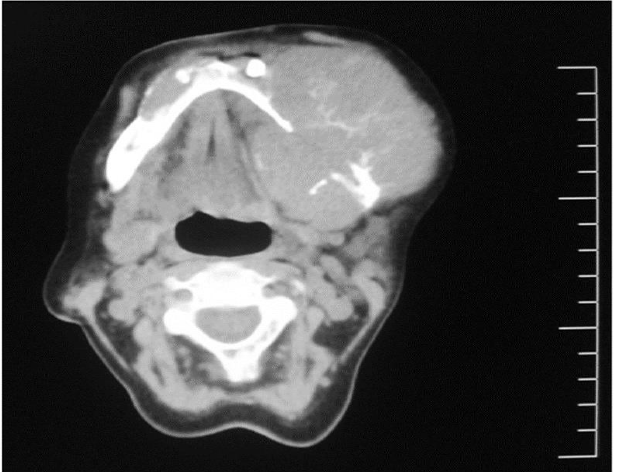
Fig. 4. The head CT scan showed a hypodense mass on the left mandibular, with the vestibular bone's cortical fenestration.